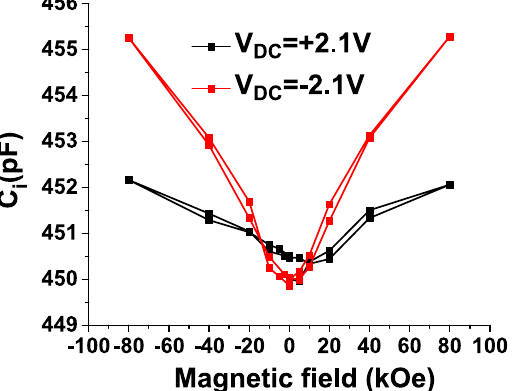
Figure 6. Magnetic field dependence of the interface capacitance C i determined at high applied